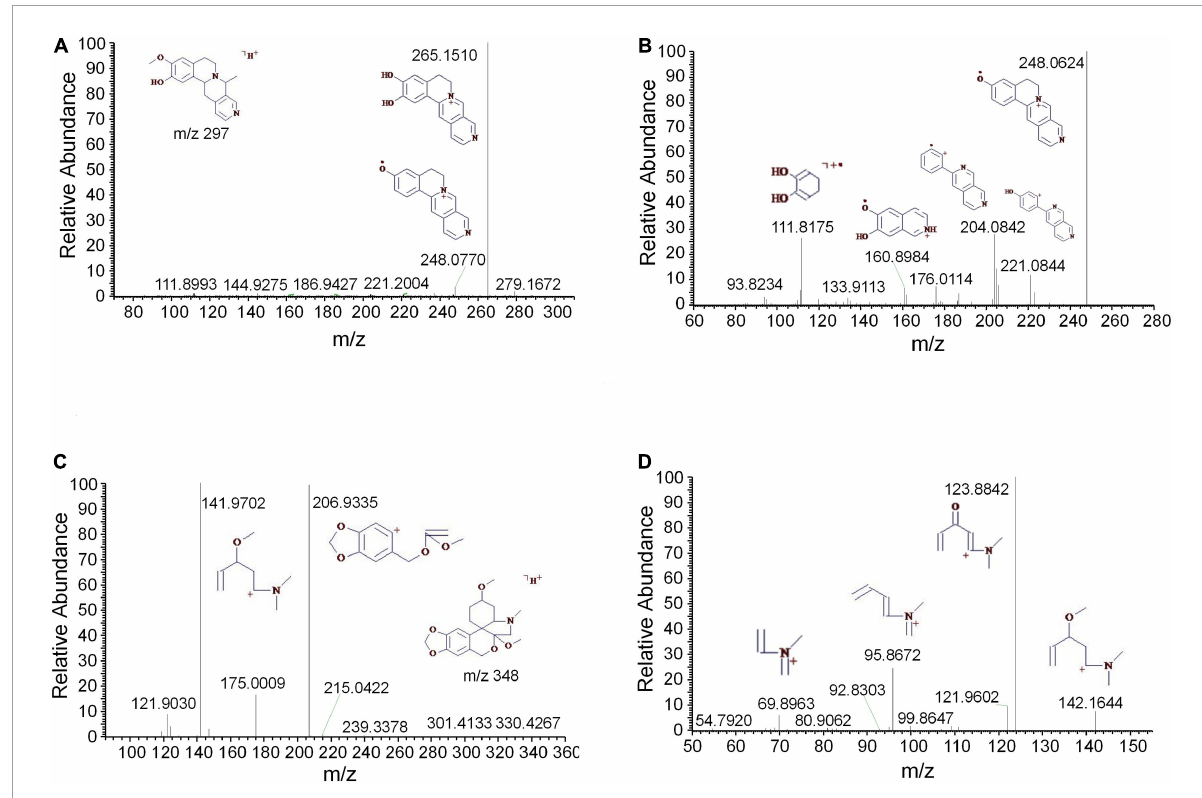
FIGURE3 The mass spectra of alamaridine and 1,2-dihydro- O -methyltazettine. (A) The MS 2 spectrum of alamaridine, (B) the MS 3 spectrum of alamaridine, (C) the MS 2 spectrum of 1,2-dihydro- O -methyltazettine, and (D) the MS 3 spectrum of 1,2-dihydro- O